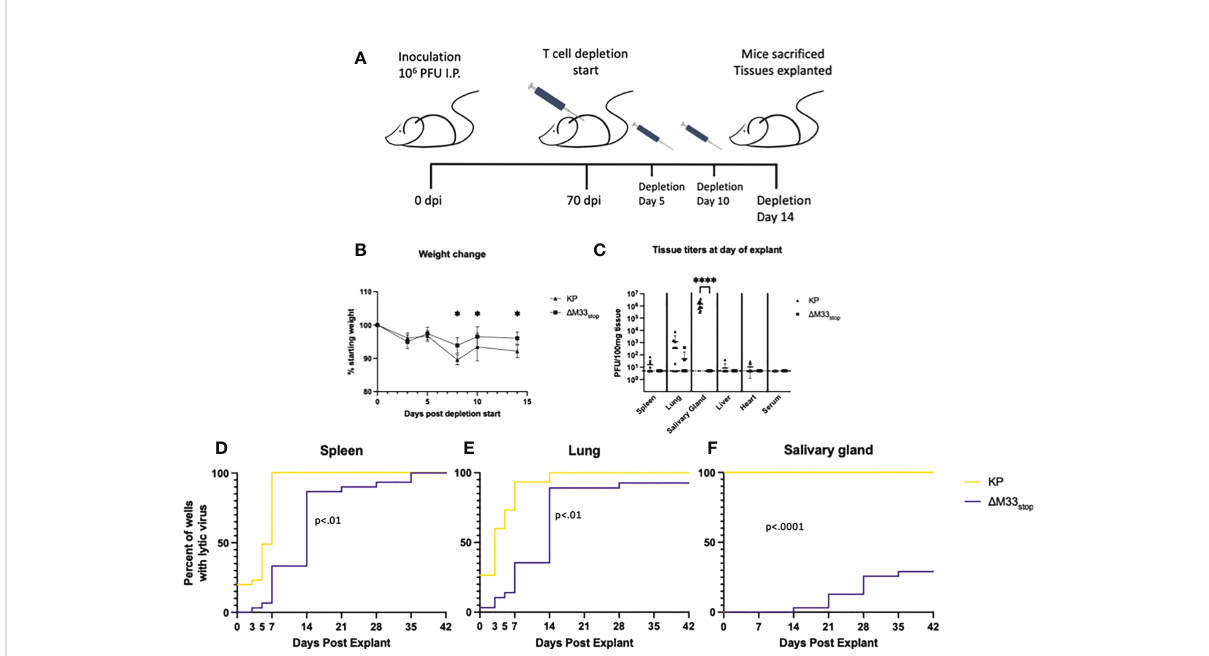
FIGURE 7 M33 is required for reactivation in vivo . Jh mice lacking B cells were inoculated IP with 10 6 PFU of either KP or D M33 stop . At 70 days post infection, T cell depletion began using cytolytic a -CD4 and a -CD8 antibodies. Mice were injected twice more, at days 5 and 10. 14 days post depletion start, mice were sacri fi ced and tissues explanted. (A) Schematic illustrating this timeline. (B) Mice were weighed periodically during T cell depletion, and D M33 stop was found to induce less weight loss, suggesting a physiological difference during MCMV reactivation. (C) Lytic virus was quanti fi ed at the time of sacri fi ce in a small piece of each tissue by plaque assay. (D-F) The remaining tissues were explanted and supernatant was collected at intervals and titered. Reactivation in the spleen (D) , lung (E) , and salivary gland (F) are shown. Data represent the percent of wells with lytic virus detectable by plaque assay, with a limit of detection of 10 PFU/ml (n=10 animals per group, totaling 30 wells per tissue). Statistical tests are ANOVA (B, C) or Mantel-Cox log-rank (D-F) . Signi fi cance is shown as *, p<0.05; ****,